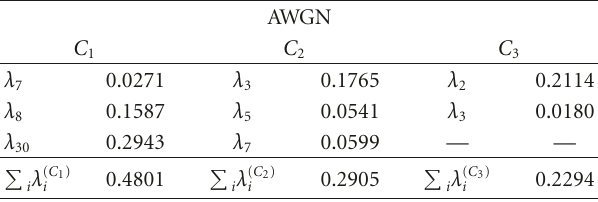
Table 1: Degree distributions for R = 1 / 2 AWGN code with α = (0 . 3, 0 . 7). The higher connection degrees are associated with the more sensitive class as done in